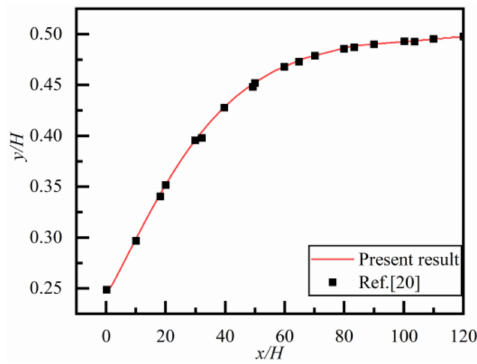
Figure 3. Particle trajectory in shear flow.